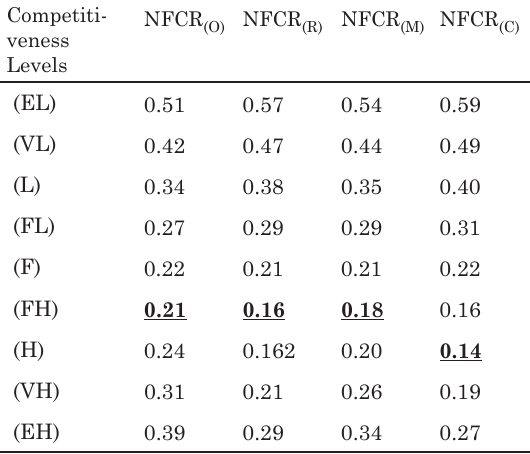
table 7. Distances between nfCr and the natural language expression set